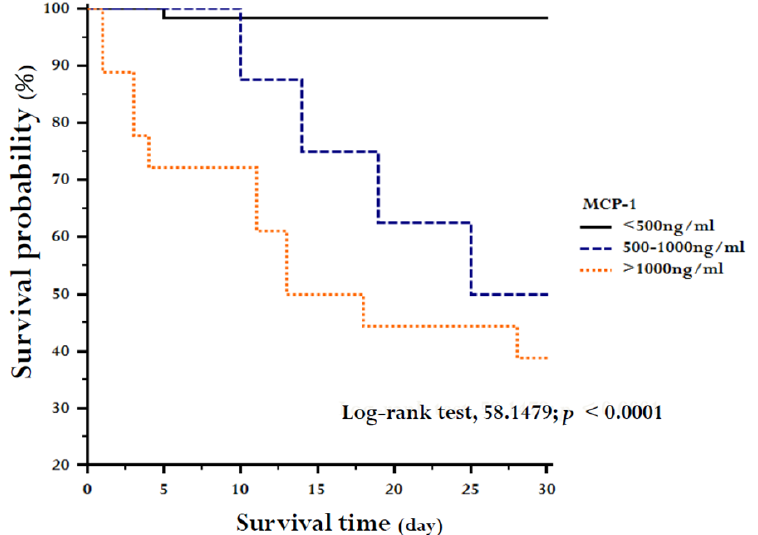
Figure 7. Kaplan–Meier estimates of survival during 28 days of study enrollment. The 87 subjects of the study were stratified into MCP-1 tertiles at enrollment.